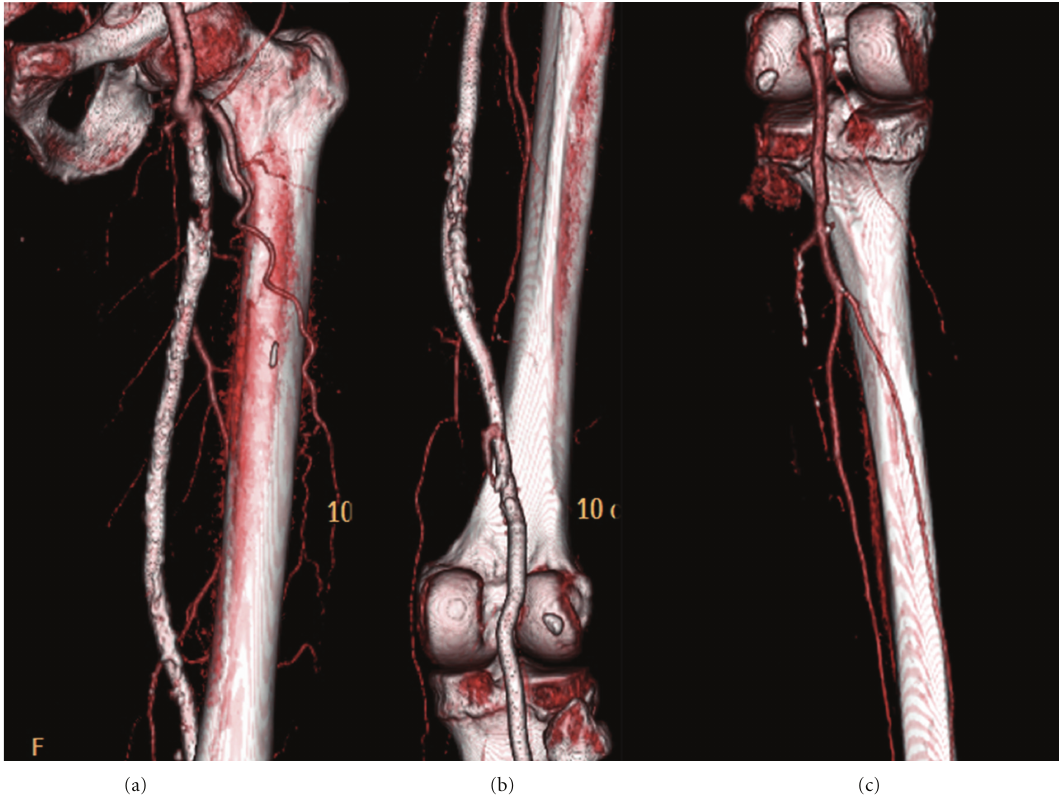
Figure 3: Three-dimensional reconstruction of computed tomography angiography demonstrating (a) the patent LSFA and (b) the exclusion of the sac of the aneurysm of the left popliteal artery with adequate distal runo ff